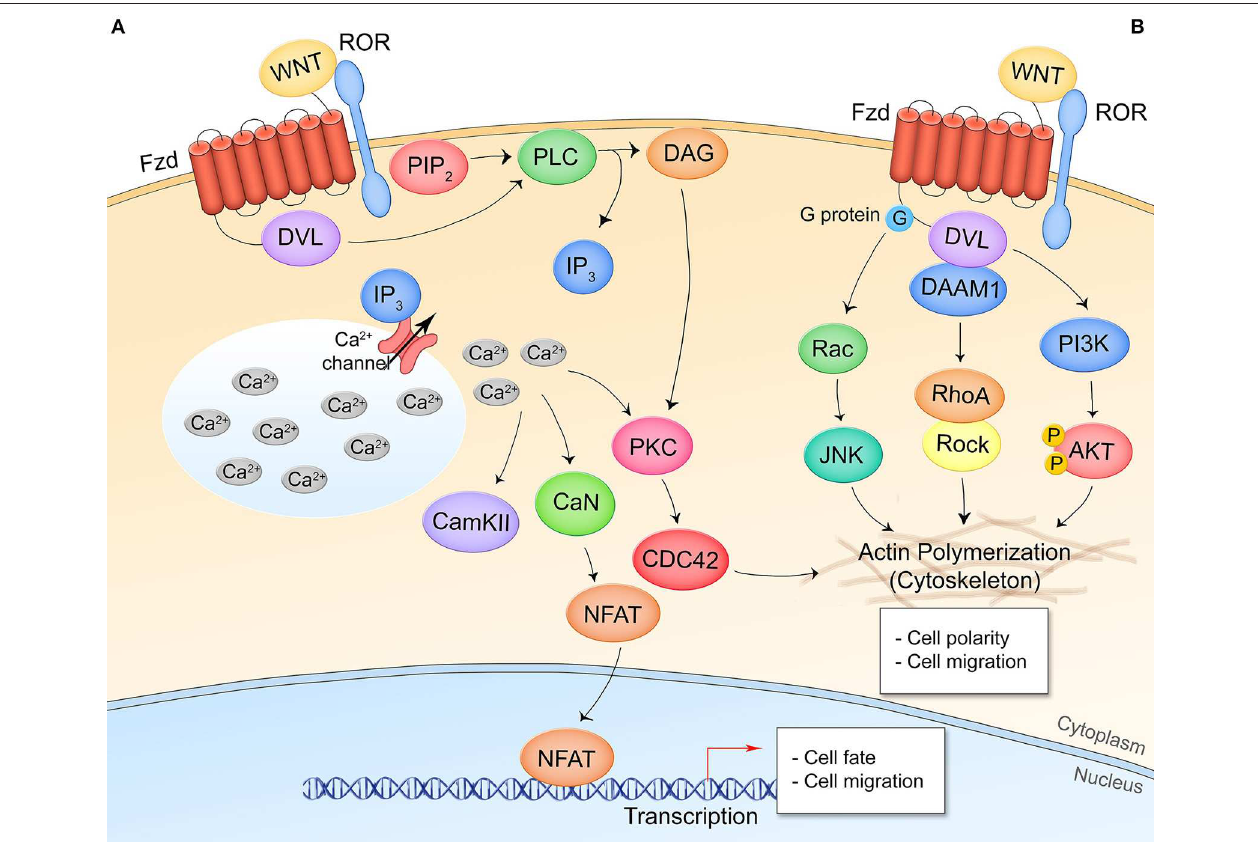
FIGURE 2 | Non-canonical/ β -catenin-independent Wnt signaling pathways. (A) Wnt/Ca 2 + signaling. A Wnt ligand interaction with Fzd and the non-canonical coreceptors ROR1/2 activates Dvl which activates PLC, leading to production of IP 3 and opening of cytosolic Ca 2 + stores. CAMKII, CaN, and PKC are activated by the increased cytosolic Ca 2 + levels. CaN dephosphorylates NFAT leading to its nuclear translocation and expression of NFAT target genes. PKC crosstalks with Wnt/PCP signaling. (B) Wnt/planar cell polarity signaling. Interaction of Wnt and respective receptor/coreceptor leads to cytoskeletal reorganization through G-protein activation of Ras-JNK signaling, Dvl-DAAM1 association and Rho activation, and Dvl activation of PI3K and Akt. This pathway is transcription-independent.